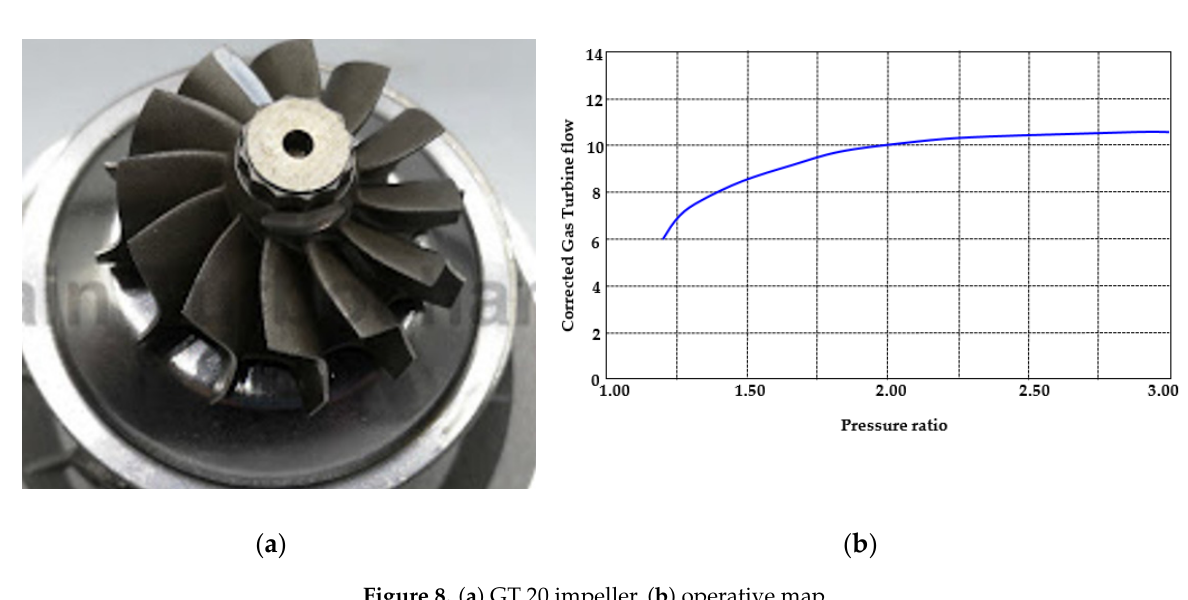
Figure 8. ( a ) GT 20 impeller, ( b ) operative map.